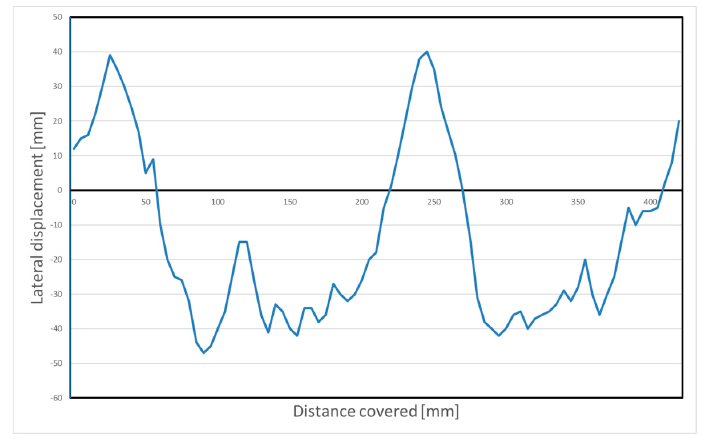
Figure 7. Line-following—displacement of the robot related to the line.